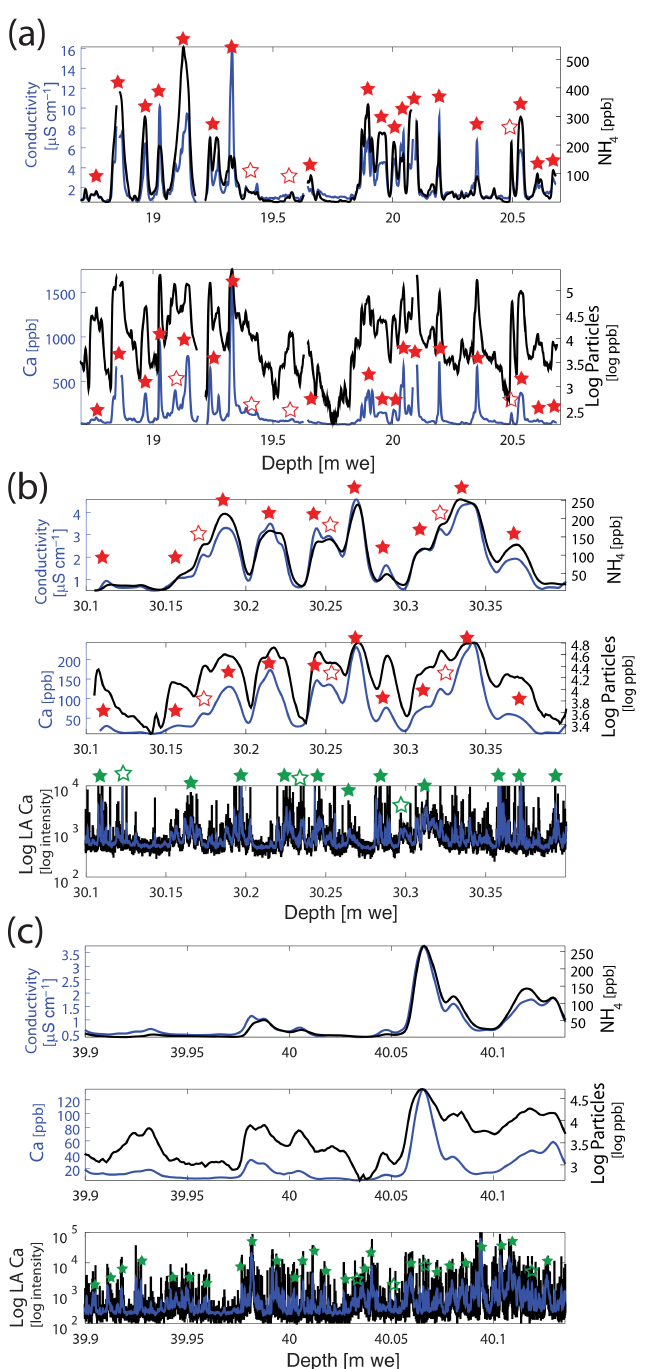
Figure 3. Examples for annual layer counting in KCC impurity profiles for three different depth sections, labelled (a) , (b) and (c) , and corresponding roughly to 100, 250 and 1000 years before 2013, respectively (see Table 3). In the upper core parts (firn sections) CFA (a) . Counted years are marked as full stars and uncertain years measured impurities were used for counting, with special emphasis on NH + 4 as white stars. (b) The middle row shows an example of overlap in counting between CFA and LA-ICP-MS Ca, showing (10 ± 3) and (11 ± 3) years, respectively. The LA-ICP-MS Ca raw signal is shown in black together with Gaussian smoothing (blue). Note that a minor depth offset (at most a few centimetres) may exist between the CFA and LA-ICP-MS datasets. Accordingly, no one-to-one match of the individual peaks is attempted. Counting within one of the deepest sections analysed for this study is shown in (c) . Here, only the LA-ICP-MS Ca allows a reliable identification of almost sub-centimetre thin annual layers. LA-ICP-MS intensity is reported as counts per